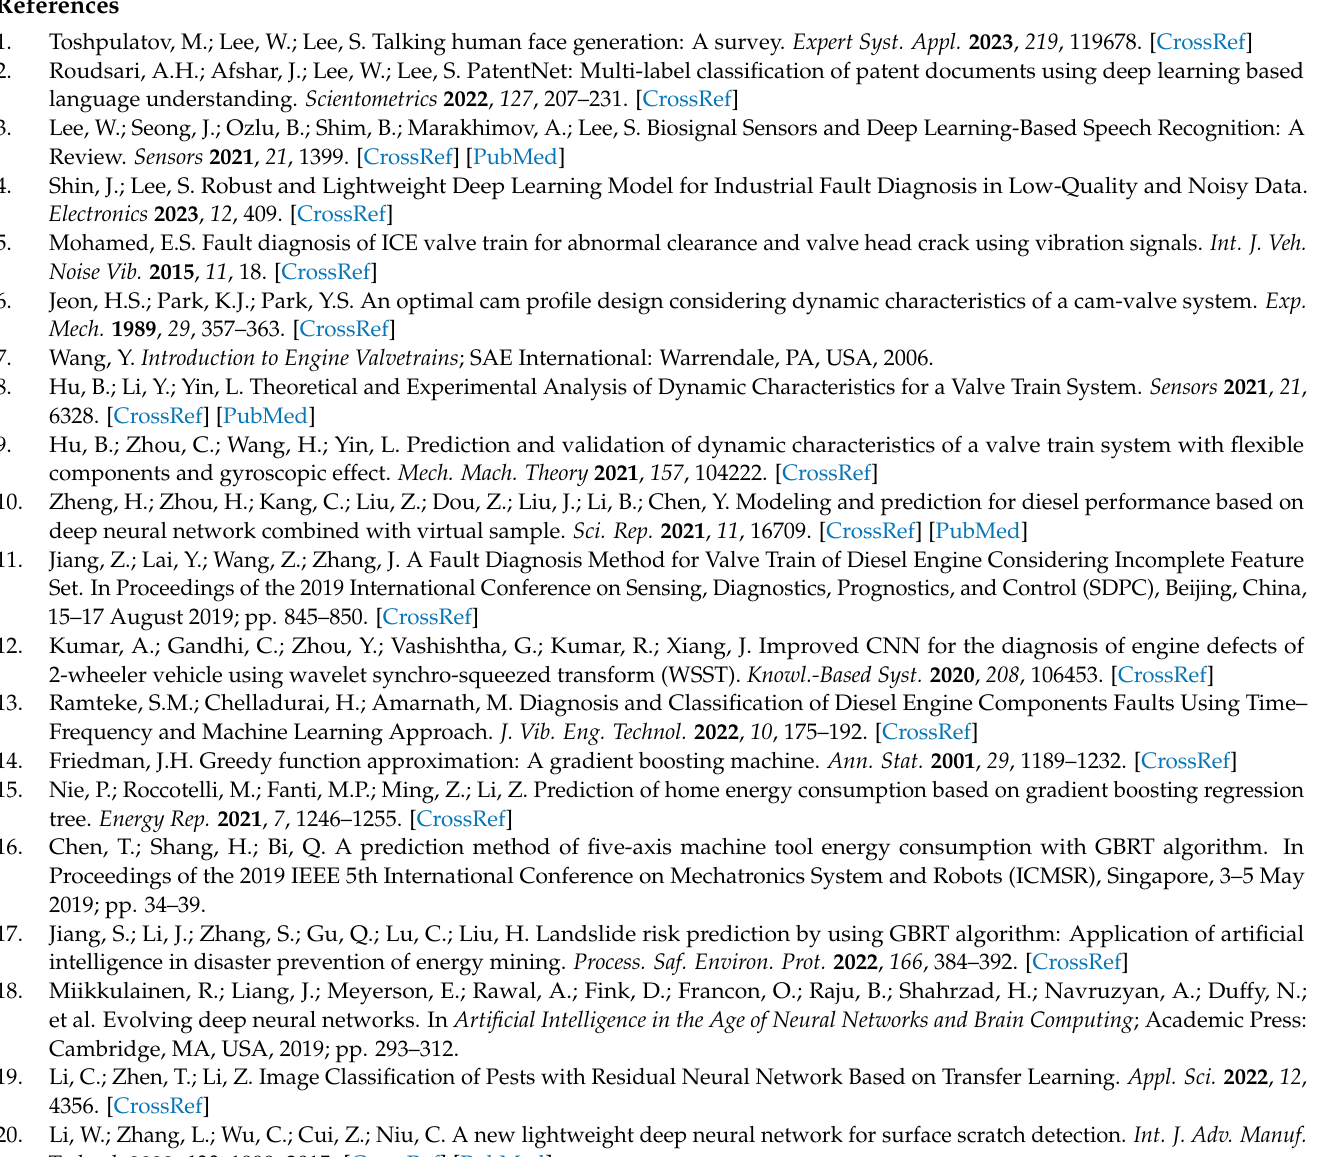
Figure A4. Comparing the actual and predicted values of the valve seating velocity throughout engine RPM using the GBRT and 1D-CNN